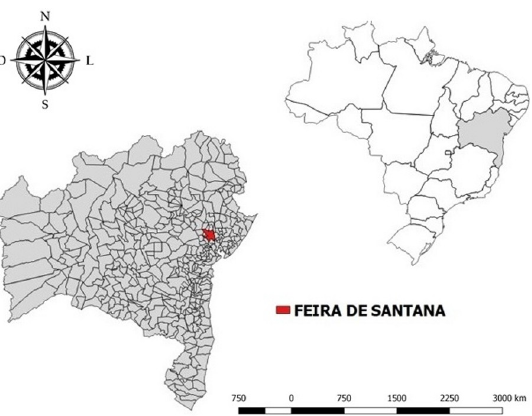
Fig 1. Maps show locations of Feira de Santana in Bahia state and Bahia state in Brazil. Map base layers were obtained from https://portaldemapas.ibge.gov.br/portal.php#mapa222663 and